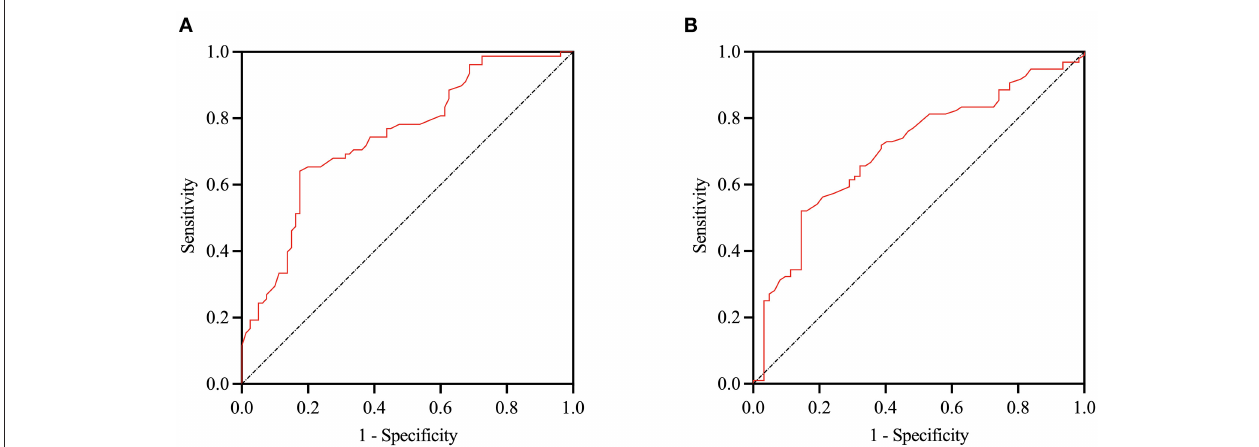
FIGURE 4 | ROC curve of serum cortisol in identification of the patients with high CSVD burden and MCI. The AUC using cortisol to detect patients with high CSVD burden was 0.745 (95% CI 0.669–0.822, p < 0.001), and patients with MCI was 0.705 (95% CI, 0.623–0.787 p < 0.001) ( A,B respectively). ROC, Receiver operating characteristicl; AUC, area under curve; MCI, mild cognitive